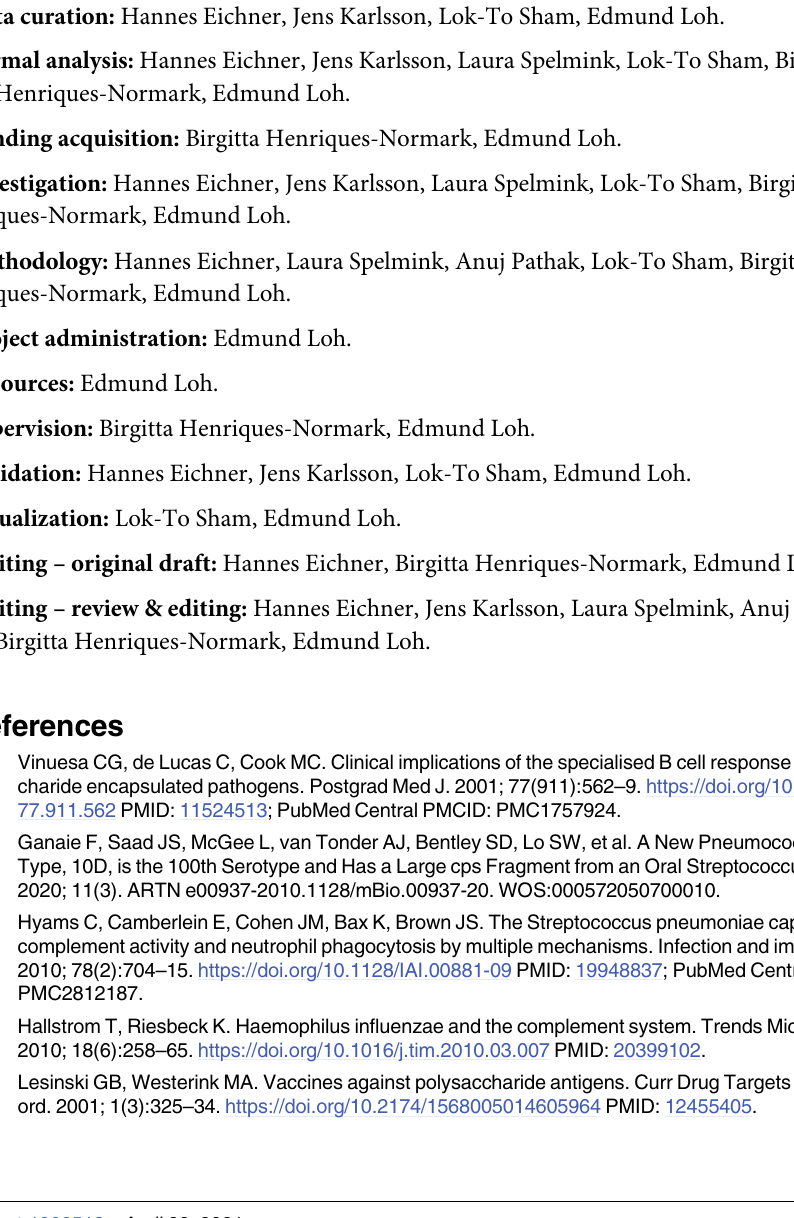
S5 Fig. Sequence comparison of the pspC 5´-UTR in different pneumococcal isolates. Poly- morphisms (red) indicated within the putative secondary structures of the S . pneumoniae pspC mRNA (see S3A